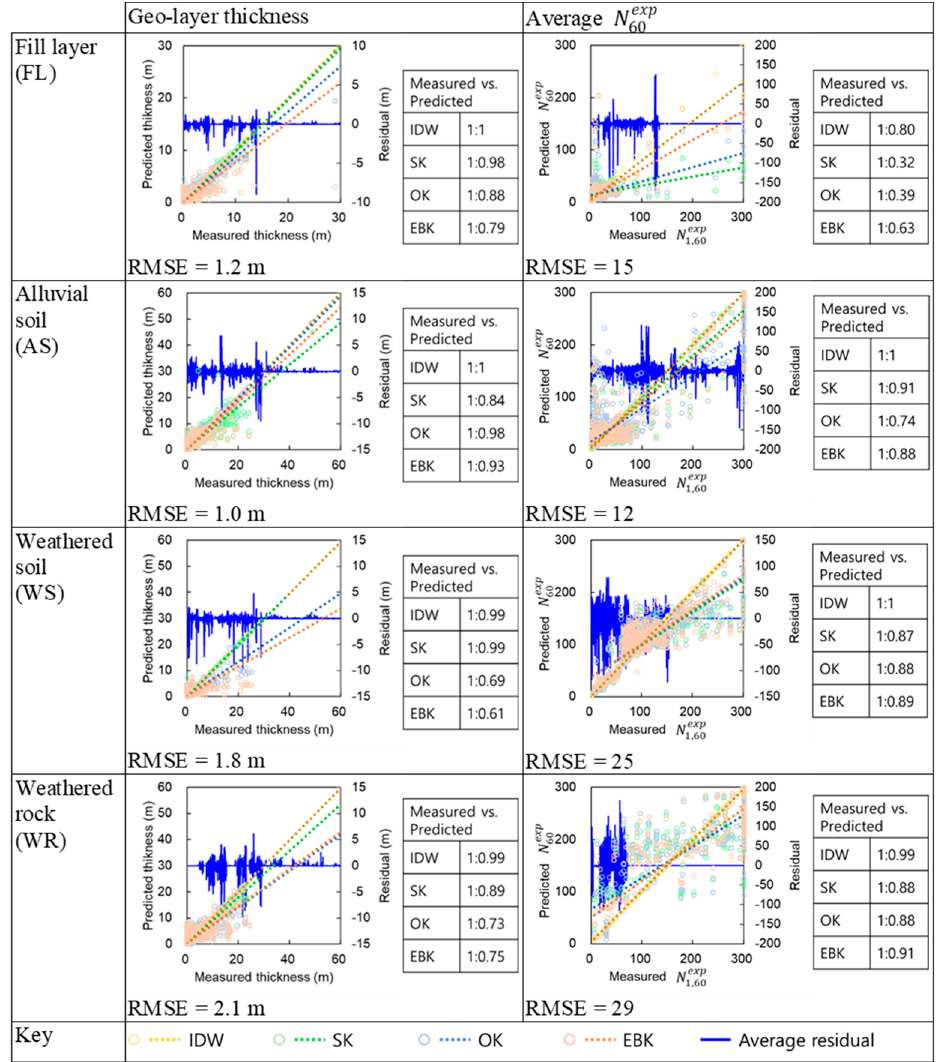
Figure 8. Correlations between measured and predicted geo-layer thicknesses and correlations with measured and predicted average N exp . The linear relations between measured and predicted values are shown by the dotted lines and summarized as tables. The residuals of prediction are shown by the blue